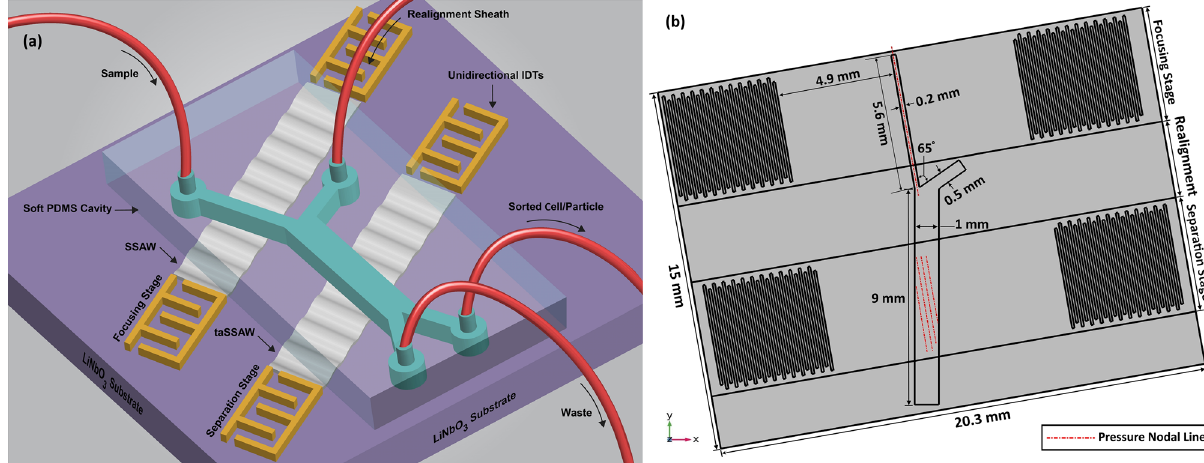
Figure 6. (a) Schematic illustration of the proposed sheathless particle separator platform using taSSAW, (b) the xy cross-section of the corresponding 3D FE model ( θ = 10°) in which detailed on-chip configuration, established pressure nodal lines, and different stages of the separation process are